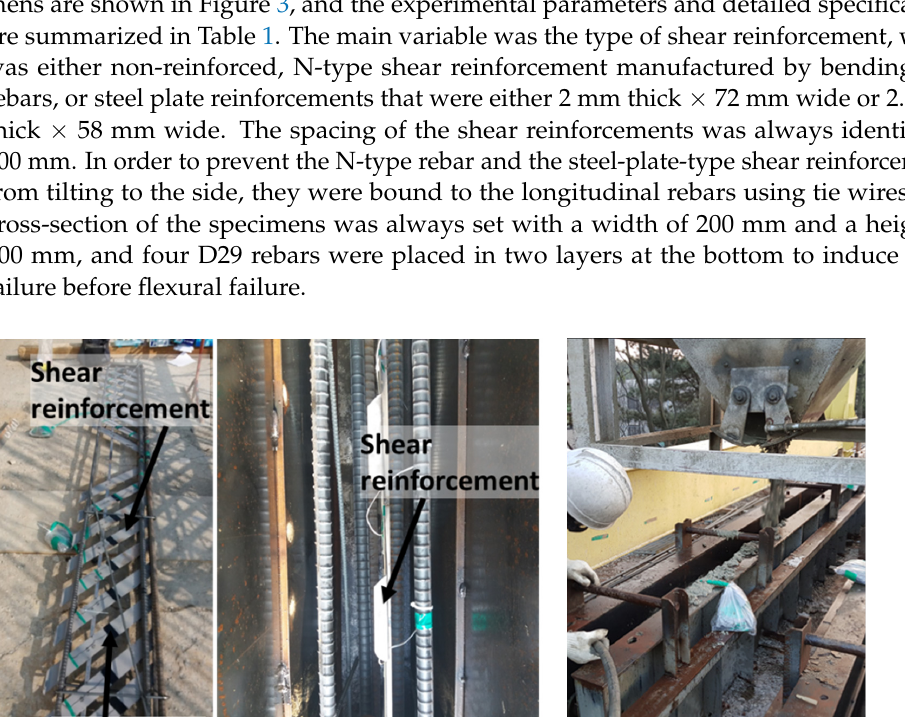
Figure 2. Test specimens’ fabrication. ( a ) reinforcement detail and gauge attachment. ( b ) Formwork installation. ( c ) Concrete casting.